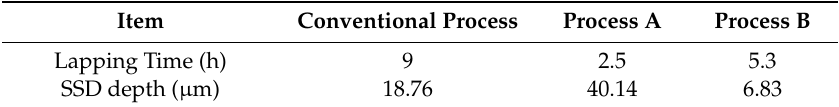
Table 2. Results under di ff erent lapping parameters.